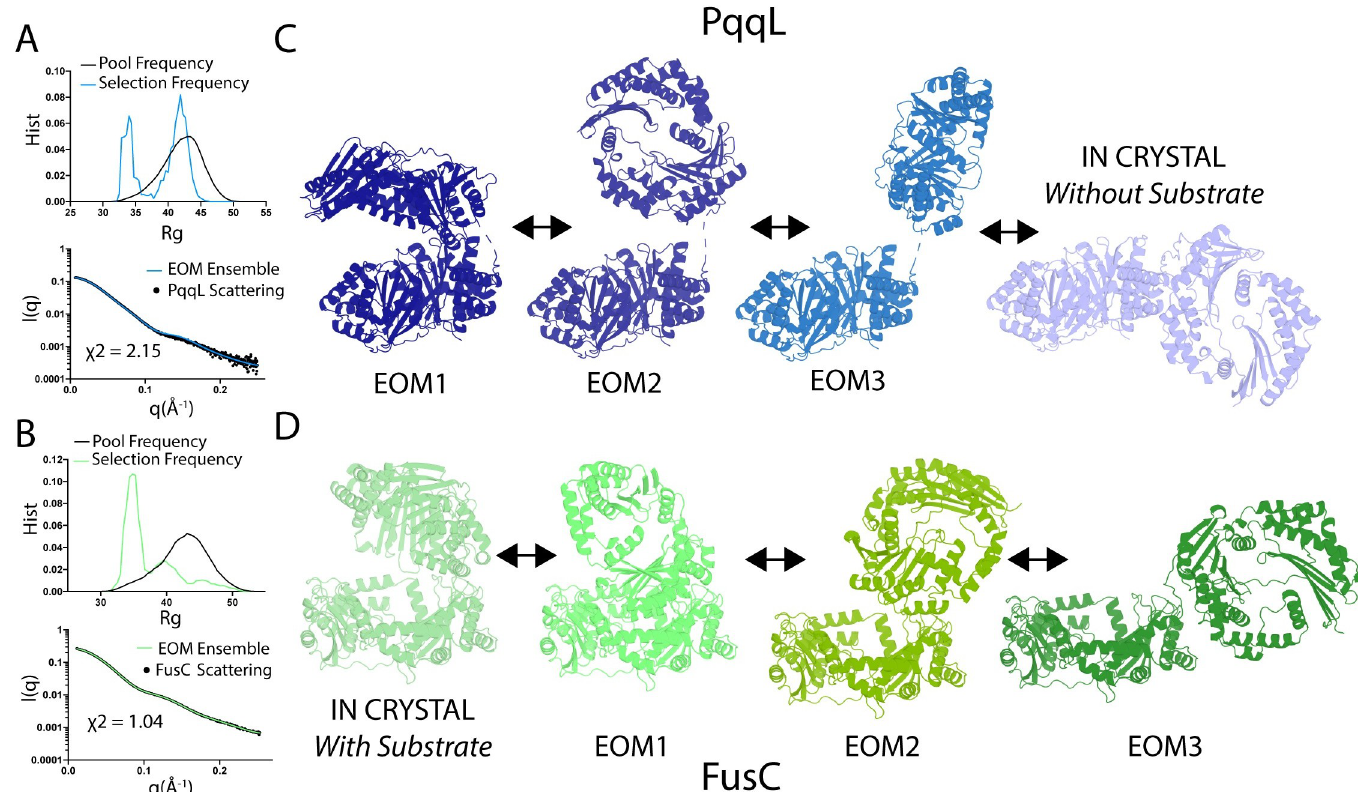
Fig 7. PqqL and FusC sample both open and closed conformations in solution. The radius of gyration (Rg) of the pool of models generated from EOM analysis and those selected the ensemble representative of solution scattering data for PqqL (A top) and FusC (B top). The fit of the ensemble of models selected by EOM for scattering data for experimental scattering for PqqL (A bottom) and FusC (B bottom). A selection of representative models from EOM analysis and the crystal structure of PqqL (C) and Fus (D), showing that both proteins are predicted to sample from open to closed conformations in solution.